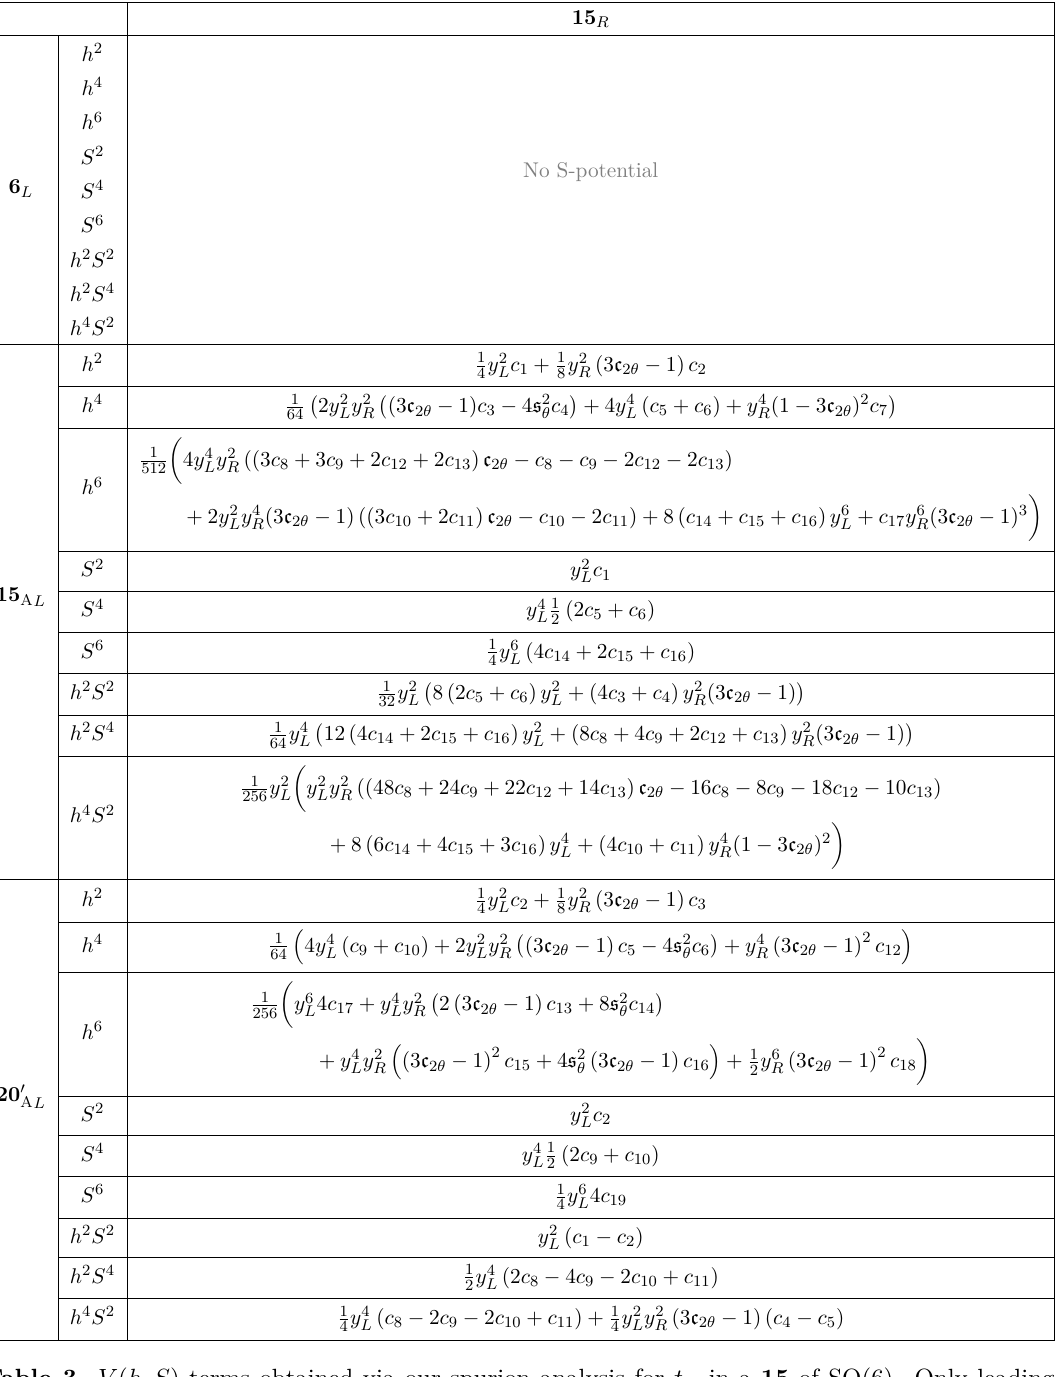
/ 16 π 2 , while every h or S comes with ∗ = sin 2 θ 15R , θ